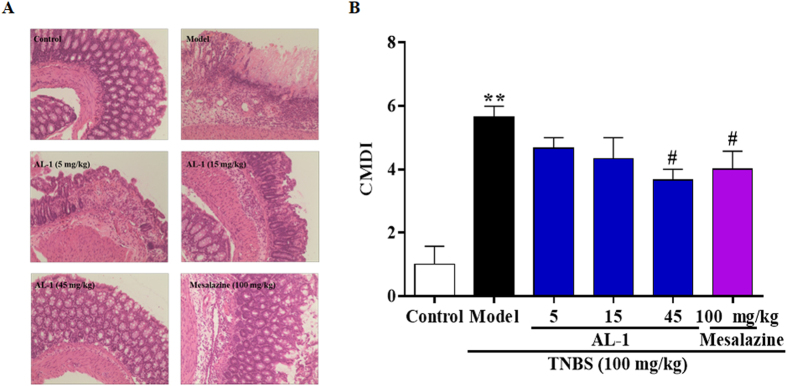
Effects of AL-1 on colonic histopathological changes.(A) Histological appearance of mice colonic mucosa after haematoxylin and eosin (H&E) stain (original magnification 100×). (B) The score of colon mucosa damage index (CMDI) of mice. Mice were challenged with solvent or TNBS at day 0 and treated with control, AL-1 (5, 15 and 45 mg/kg) or mesalazine (100 mg/kg) for days 0–3. After sacrificed at day 3, sections of the colon were collected, embedded in paraffin, and cut into 4 μm of sections and stained with hematoxylin and eosin before examination. Values were shown as the means ± SEM, n = 8 for each group. **P < 0.01 vs control group, ##P < 0.05 vs mice treated with TNBS alone.